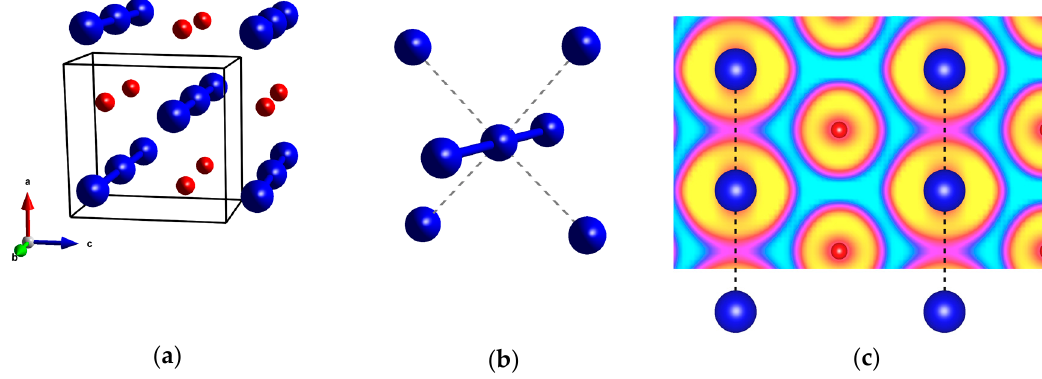
Figure 5. ( a ) the P2/m structure of KrF; ( b ) the coordination environment of Kr with secondary Kr–Kr contacts marked with dashed lines; ( c ) ELF function for KrF at 150 GPa. Yellow color depicts ELF values above 0.9, cyan—below 0.1, while magenta corresponds to values of 0.4. Shortest Kr–Kr contacts are marked with dashed lines.